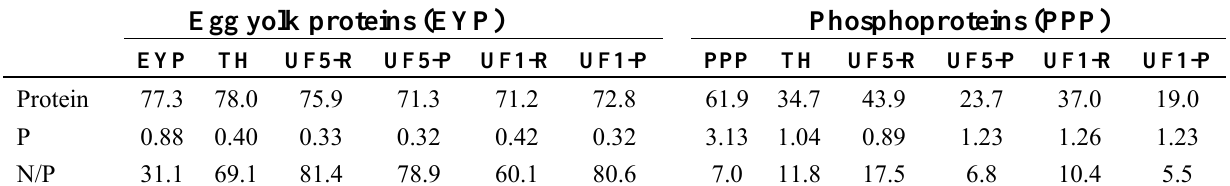
Table 2. Protein and phosphorus (P) contents (%, w/w dry basis) and N/P atomic ratio of egg yolk proteins, phosphoproteins, their enzymatic hydrolysates and UF-fractions. Egg yolk proteins (EYP) Phosphoproteins